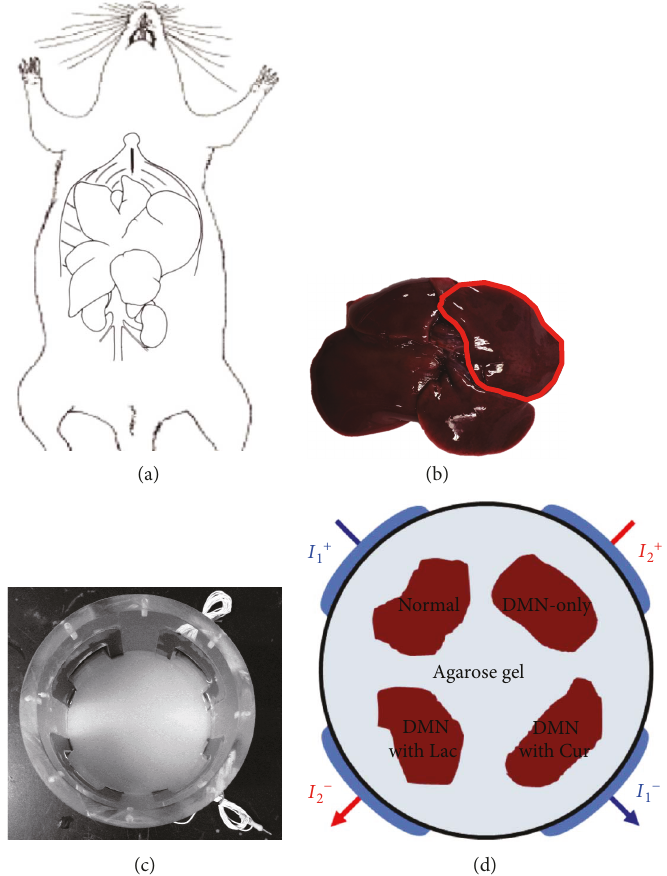
Figure 1: Experimental setup for MREIT conductivity imaging of liver phantom. (a) The whole liver was removed, and (b) the liver block was resected for phantom imaging. (c) A cylindrical acrylic phantom was fi lled with agarose gel of 1.0S/m conductivity to support the liver block. (d) Electrodes were attached to the sides of the phantom to inject imaging